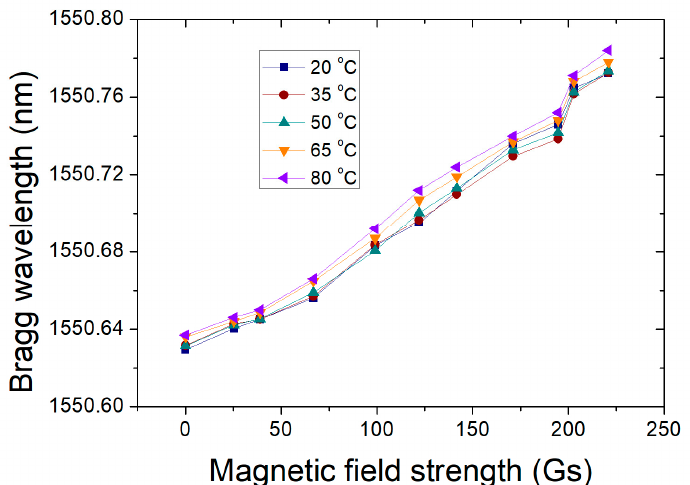
Figure 8. The Bragg wavelength varies with the applied magnetic field at different temperatures.